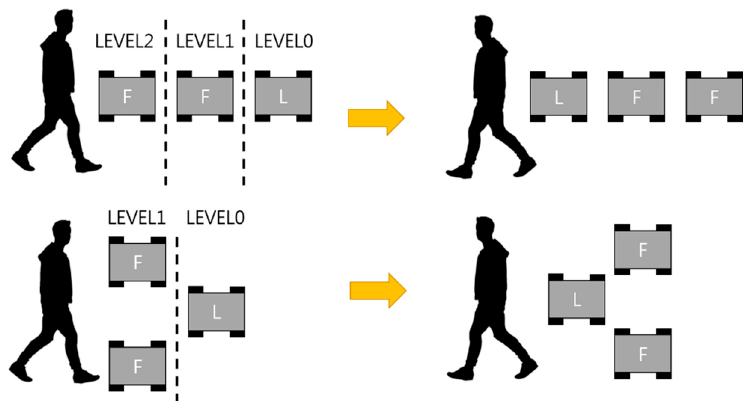
Figure 10. Examples of master change and formation change.